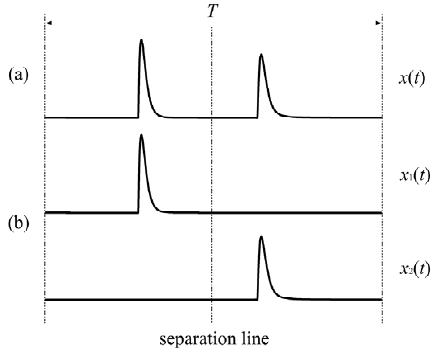
Figure 2. The PD pulses; ( a ) before pulse separation; ( b ) after pulse separation.